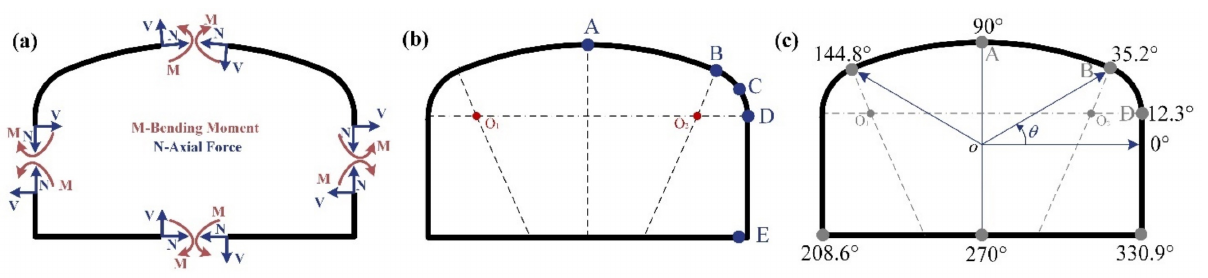
Figure 14. ( a ) sign convention of internal forces ( b ) time histories monitoring positions of the tunnel ( c ) the angle of the tunnel position relative to the center of the tunnel. ( c ) the angle of the tunnel position relative to the center of the